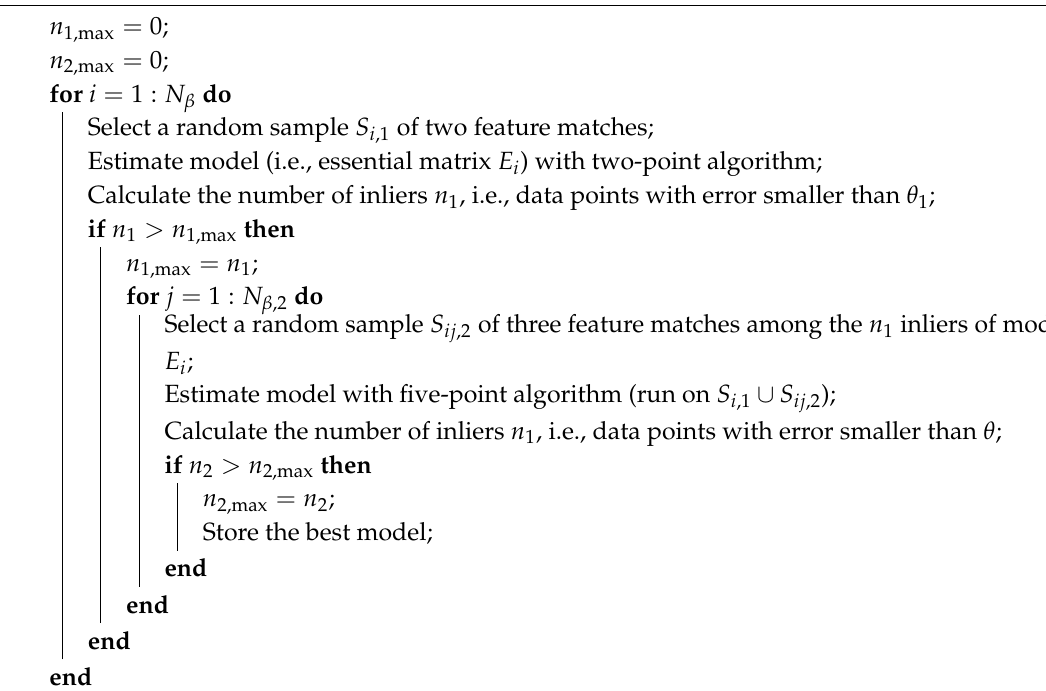
Algorithm 2: Two-step